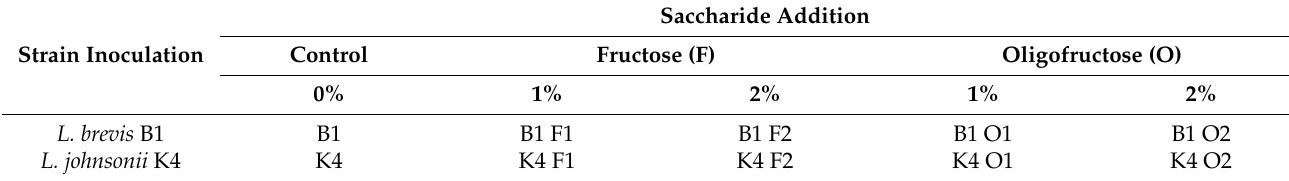
Table 5. Experimental